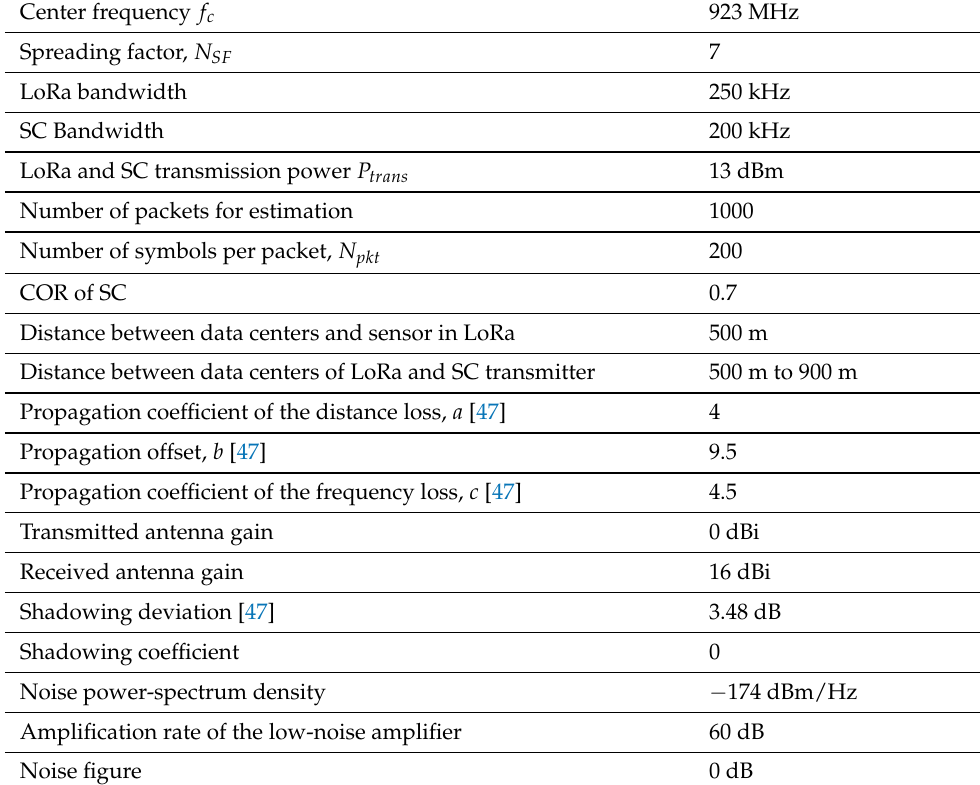
Table 1. Wireless system parameter in computer simulation.